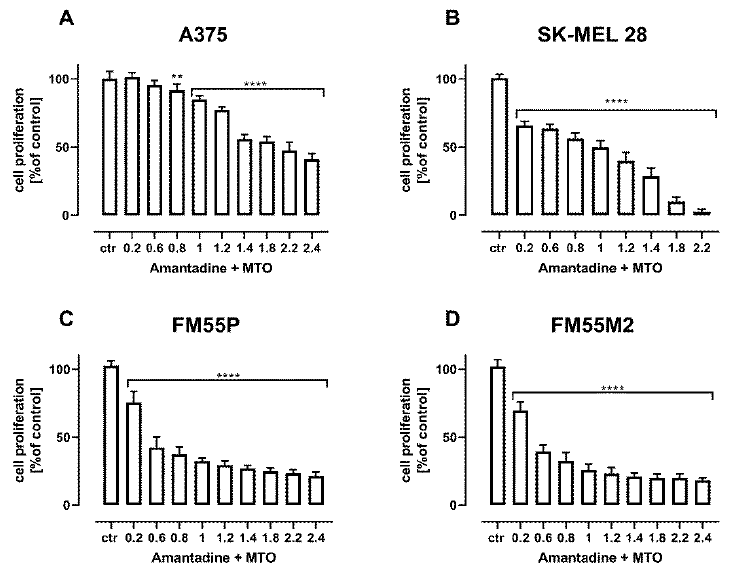
Figure 12. The effect of combination of amantadine and MTO in fixed ratio 1:1 on the proliferation of malignant melanoma cell lines (A375 ( A ), SK-MEL28 ( B ), FM55P ( C ) and FM55M2 ( D )) was measured by BrdU assay after 72 h. Results are presented as mean ± SEM at each concentration. (** p < 0.01; **** p < 0.0001). The values on axis X represent the multiplicity of calculated IC 50 (1.0 means half IC 50 of amantadine + half IC 50 of MTO).